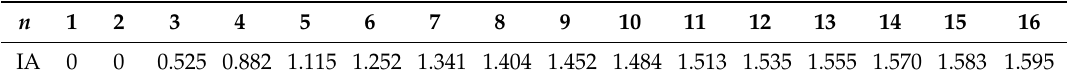
Table 3. Random Index ( RI ) value for each “ n ” in the